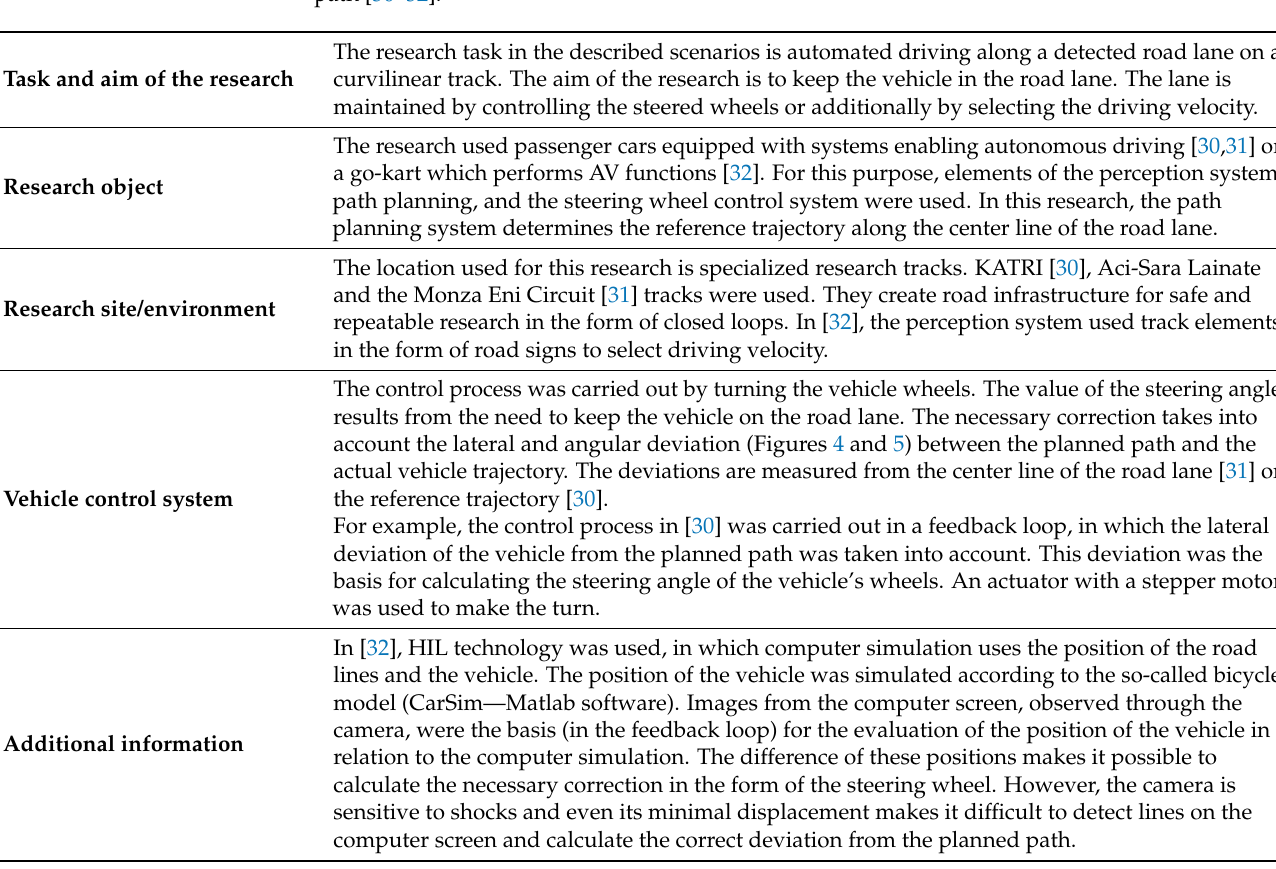
Table 1. The main features of the test scenario for planning and maintaining the vehicle’s driving path [30–32].